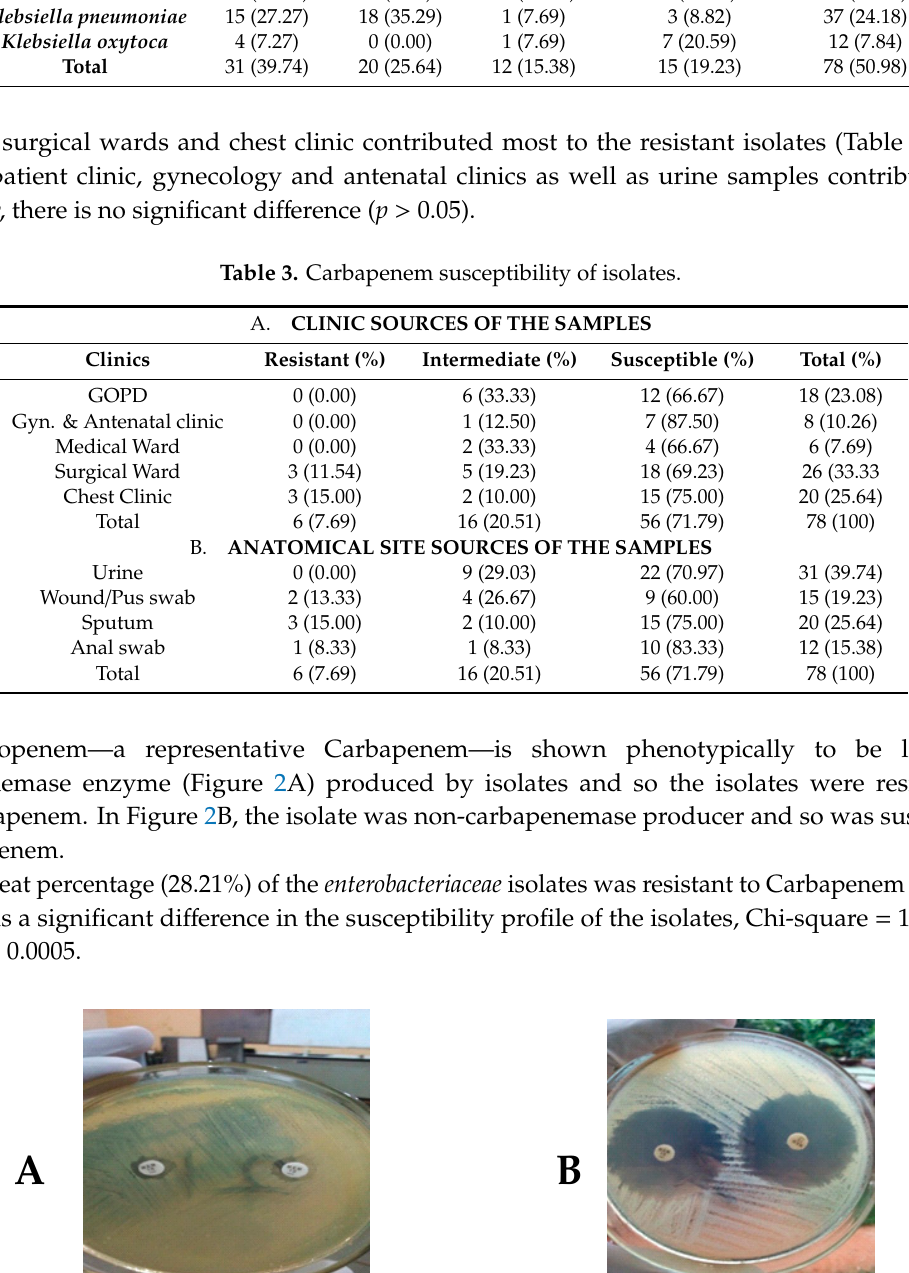
Table 2. Percentage (%) Prevalence of Isolates in the samples.